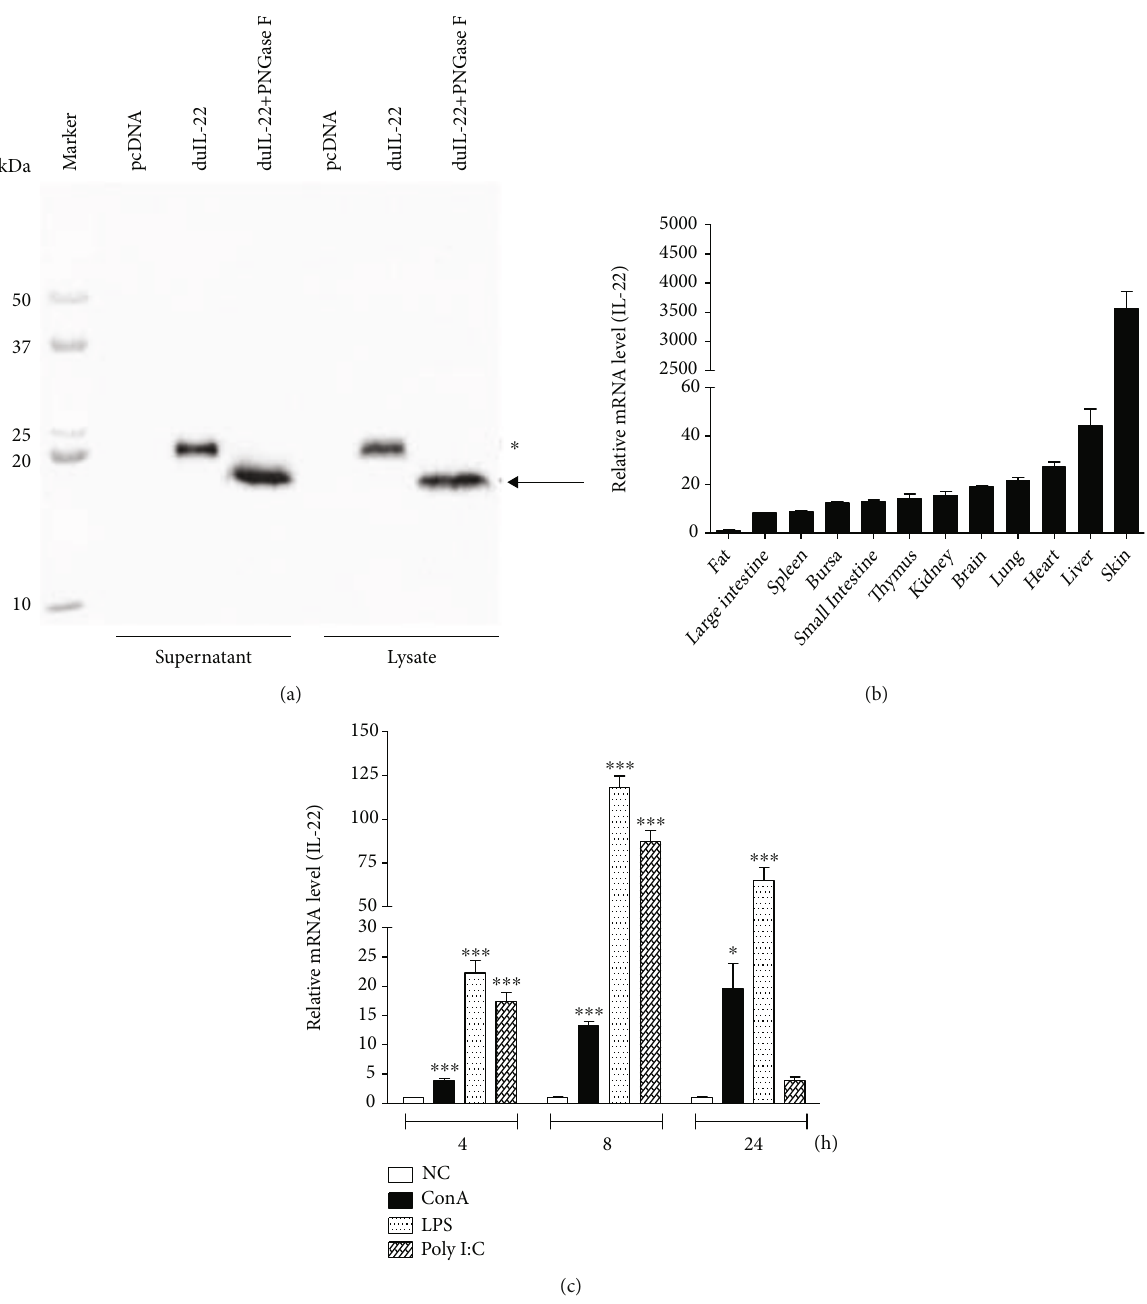
Figure 2: Molecular weight of duck IL-22 and its expression in normal tissues and stimulated splenic lymphocytes. (a) Western blot analysis to determine molecular weight of duck IL-22 protein from COS-7 cells transfected with duIL-22-MYC construct. Supernatants and cell lysates of COS-7 cells were obtained at 48 h after transfection and deglycosylated using PNGase F (100U peptide- N -glycosidase F) at 37 ° C for 1 h. Supernatants and cell lysates under reducing conditions were separated using SDS-PAGE. An anti-MYC antibody was used to detect the speci fi c bands of duck IL-22. The asterisk ( ∗ ) and arrow indicated the normal bands and the deglycosylated bands of duck IL-22, respectively. (b) Distribution of IL-22 transcripts in normal healthy duck tissues. Total RNA was obtained from tissues of two- week-old normal ducks ( n = 5 ) and used to qRT-PCR analysis. Expression levels of β -actin were used for normalization of IL-22 expression levels, which were calibrated to the lowest expression level detected. Results are presented as the mean ± SE values from 2 independent experiments. (c) Duck IL-22 expression levels in mitogen-treated splenic lymphocytes. The lymphocytes were obtained from two-week-old normal ducks using Ficoll density gradient centrifugation. They were activated using 25 μ g/ml poly I:C, 10 μ g/m LPS, or 10 μ g/ml ConA for the indicated times. Expression levels of β -actin gene were used for normalization of IL-22 expression level, which were calibrated with untreated cultured splenic lymphocytes (NC). Results are presented as the mean ± SE values from 2 independent experiments performed in triplicate. ∗ P < 0 : 05 and ∗∗∗ P < 0 : 001